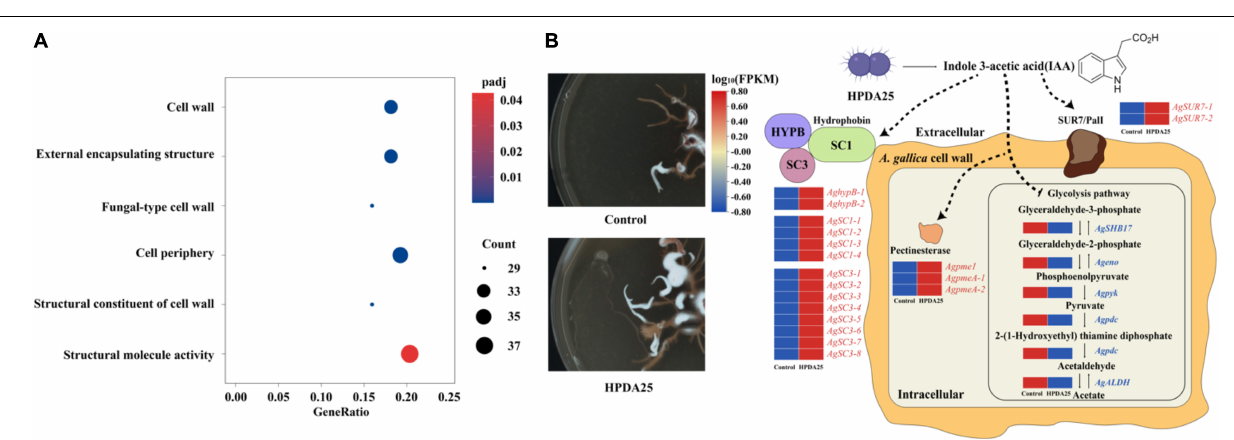
FIGURE 6 | Mechanism of HPDA25 promotes growth of A. gallica . (A) Number of DEGs in A. gallica co-cultured with HPDA25 in GO annotation. (B) Mechanism of HPDA25-mediated promotion of A. gallica growth. Upregulated DEGs were in red words; downregulated DEGs were in blue